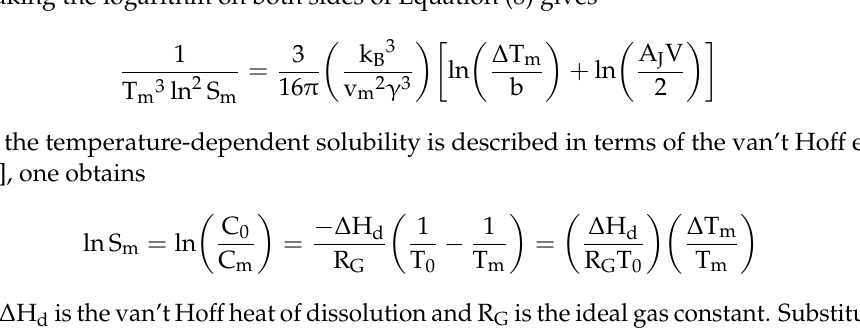
Figure 1. A schematic diagram [16] showing the increasing of supersaturation during the cooling process for the saturated concentration at C 0 ( ○ represents the starting point and ● represents the nucleation point at a given R).